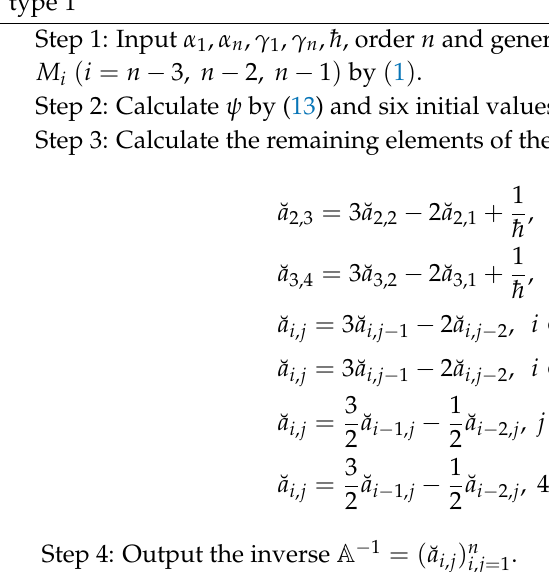
Algorithm 2: The inverse of a periodic tridiagonal Toeplitz matrix with perturbed corners